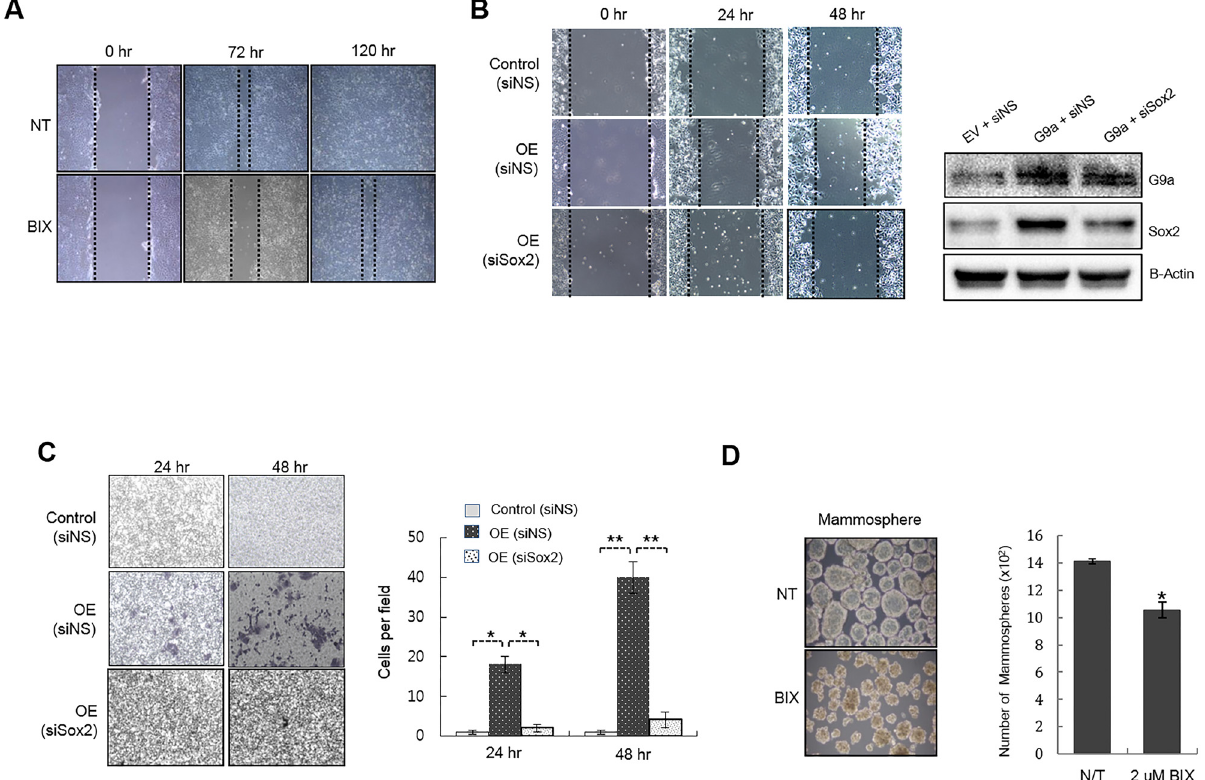
Fig 3. Expression level of G9a is correlated with the migration and invasion of MCF7 cells. (A) Wound-healing assay examining the effect of chemical inhibition of G9a activity on the migration of MCF7 cells. MCF7 cells were treated with 0.2 μ M BIX-01294 and wounded using a micropipette tip when the cells were fully confluent. Cell migration was then monitored. (B) Wound-healing assay to examine the effect of ectopic expression of G9a on the migration of MCF7 cells. MCF7 cells were transfected with control or G9a expression plasmids and then re-seeded for the migration assay. When fully confluent, the cells were wounded using a micropipette tip, and cell migration was photographed at the indicated times. (C) The effect of G9a on the invasiveness of MCF7 cells was examined in a Transwell invasion assay. MCF7 cells were first transfected with control or G9a expression plasmids along with siNS or siSox2. Twenty- four hours later, cells were suspended in serum-free medium and seeded in 24-well Matrigel-coated Transwell chambers. Cells crossing the Matrigel-coated filter were fixed and stained with Crystal violet. The number of stained cells was then counted. Representative pictures are shown (left panel). The average number of stained cells in five random microscopic fields from three independent experiments is presented graphically (right panel). (D) The effect of G9a on the mammosphere-forming ability of MCF7 cells was examined in cells maintained under low-serum non-adherent culture conditions for 7 days in the presence or absence of 2 μ M BIX-01294. Abbreviations: NT, no treatment; Control (siNS), cells transfected with a control plasmid and non-specific siRNA; OE (siNS), cells transfected with a G9a-expressing plasmid and non-specific siRNA; OE (siSox2), cells transfected with a G9a-expressing plasmid and siSox2. * P < 0.05 and ** P < 0.01 compared with the control group. Data are expressed as the mean ± SD and representative of three independent experiments.